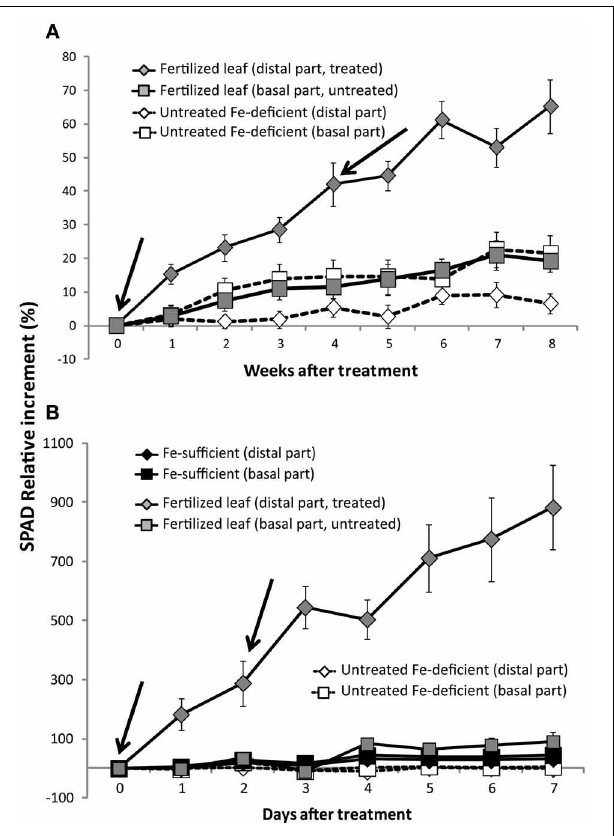
FIGURE 3 | Time course of the relative changes in leaf SPAD values in peach tree (A) and sugar beet leaves (B). The treatment was carried out with a solution containing 2mM FeSO 4 and 0.1% surfactant. In peach leaves, foliar treatments were made at weeks 0 and 4, and the SPAD index was measured each week. In sugar beet leaves, the treatment was made at days 0 and 2 and the SPAD index was measured daily. Peach tree data are means ± SE ( n = 11 trees: 3 in 2009, 4 in 2010, and 4 in 2011; each sample was composed of 20 leaves, each from a different shoot from the same tree; two measurements were taken per half-leaf). Initial SPAD values in chlorotic peach tree leaves were 18 ± 2. Sugar beet data are means ± SE ( n = 8 plants, 4 in each of two different batches; each sample was composed of four leaves from the same plant; four measurements were taken per half-leaf). Initial SPAD values in sugar beet chlorotic leaves were 11 . 5 ± 1 . 5.